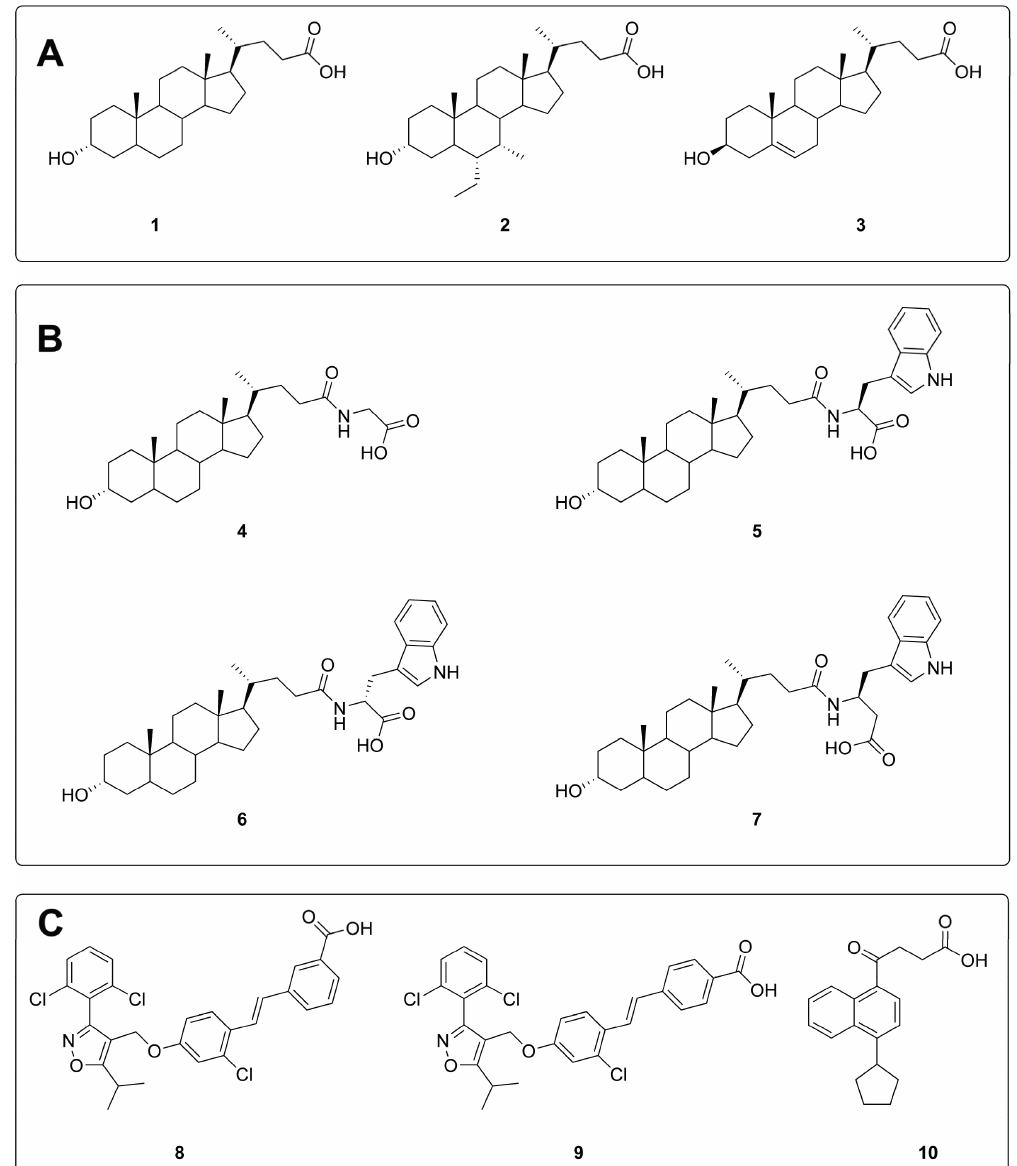
Figure 2. Known antagonists of the EphA2 receptor included in the VS analysis, divided according to their